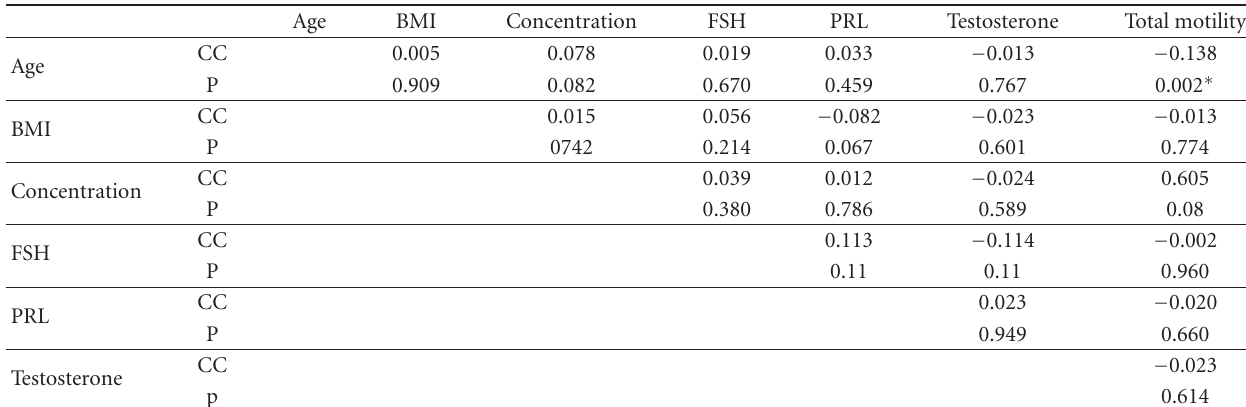
Table 3: Correlation of di ff erent variables.